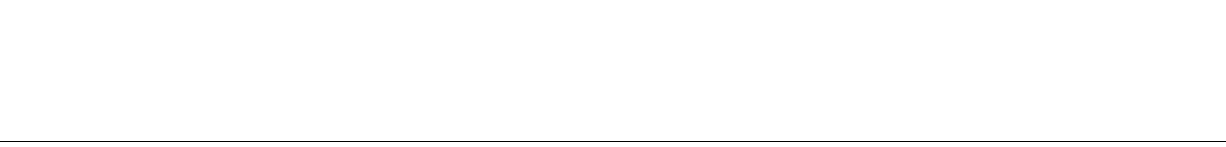
TABLE 1 | Different “ top-down ” and “ bottom-up ” approaches in synthesizing C-Dots. Approaches